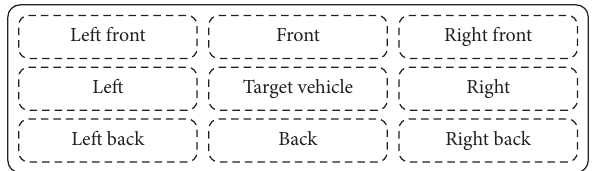
Figure 7: Example individuals in traffic